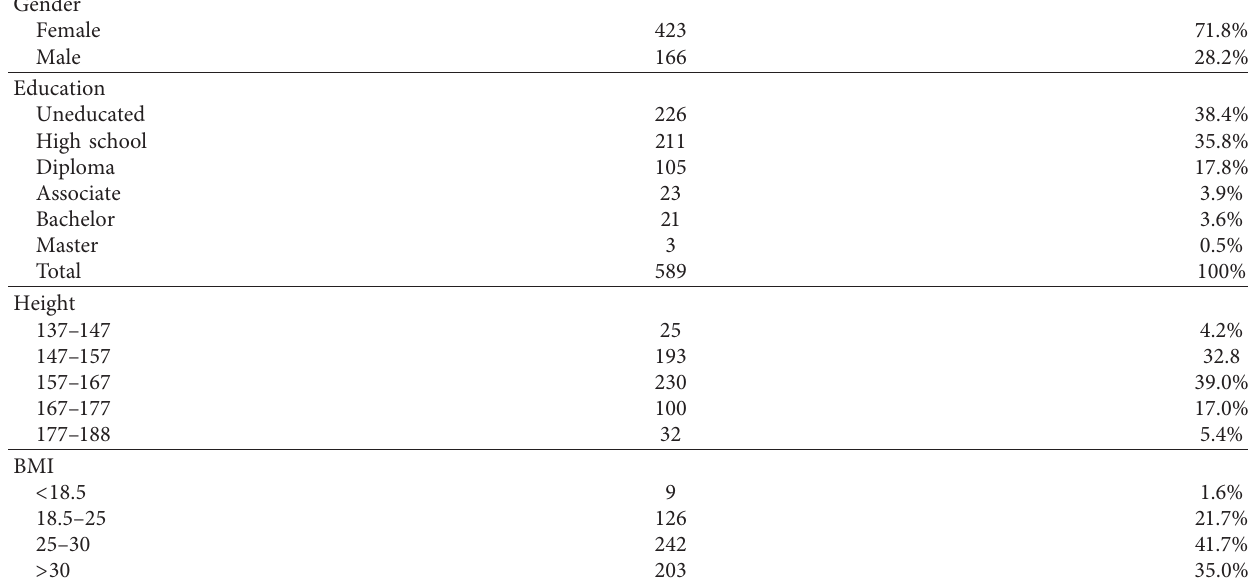
Table 1: Demographic characteristics of the participants in the